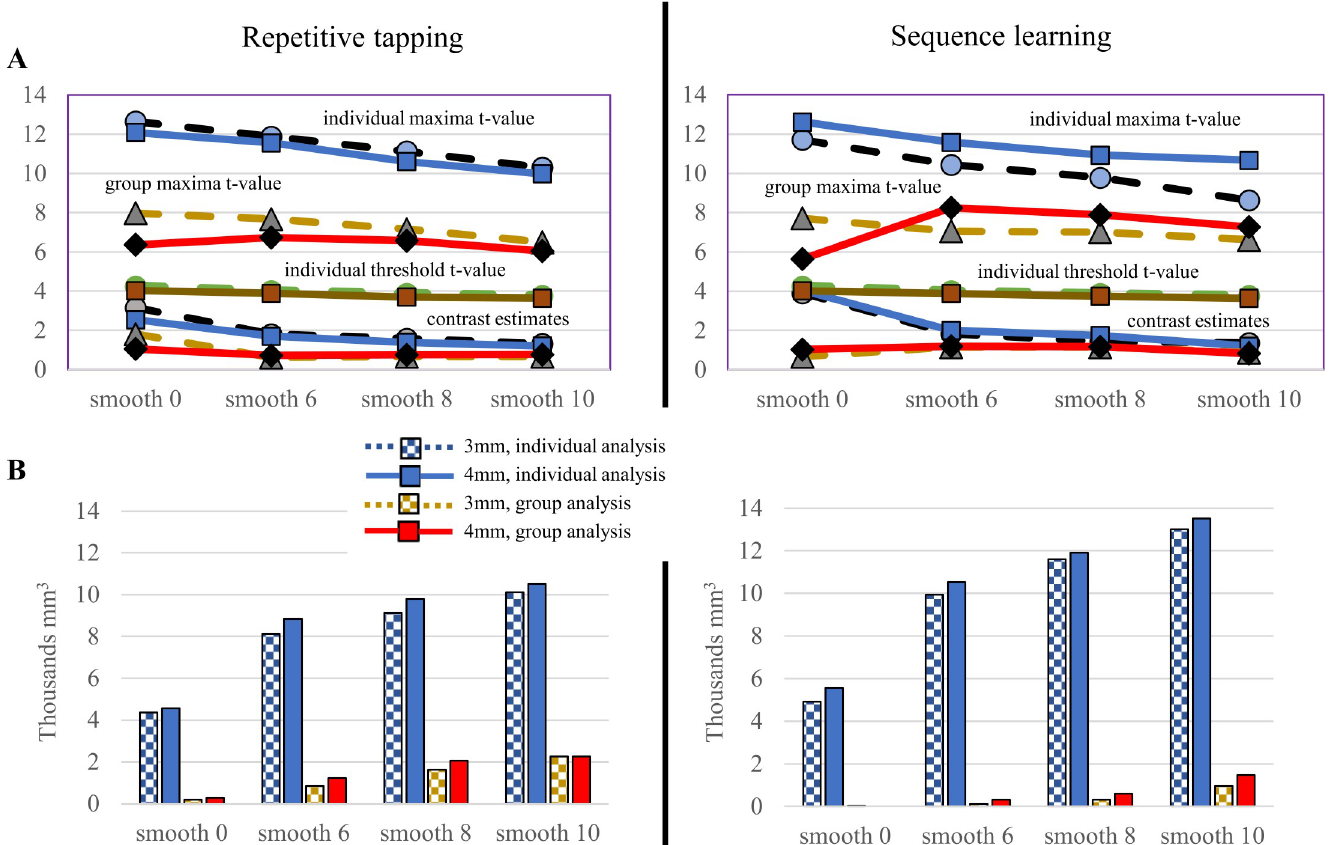
Fig 1. Effects of smoothing kernel and voxel size on SMC individual and group activation during motor tasks. (A) Threshold and parameters from the activation maximum, plotted with no smoothing (“smooth 0”) and three smoothing kernels applied to 3- and 4-mm isovoxels (solid and dashed lines, respectively). Both for repetitive tapping and sequence learning, parameter differences related to voxel size were small for both individual and group analysis; in both, increases in smoothing kernel above 6mm resulted in small decreases in threshold, magnitude of the contrast, and maximal t-value, with group analyses yielding overall lower values than individual analyses. (B) Despite decreases in parameter values, increases in the size of the smoothing kernel produced larger activation volumes, reflecting the decreased threshold and variability in SMC signal within (blue) and between individuals (gold and red).